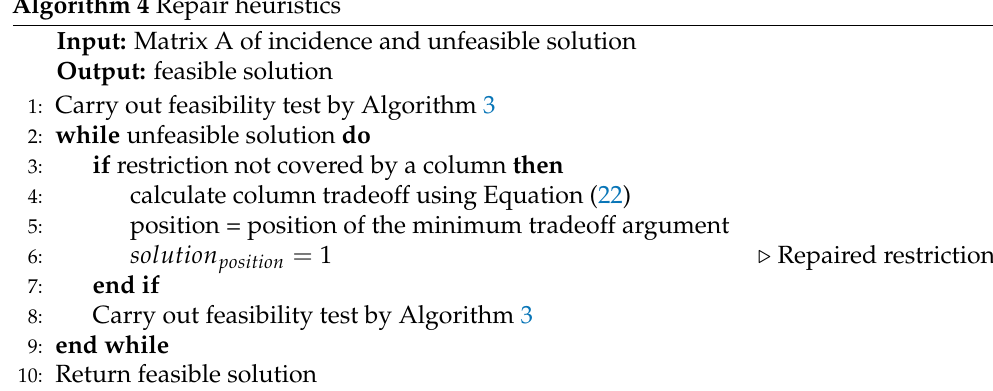
Algorithm 4 Repair